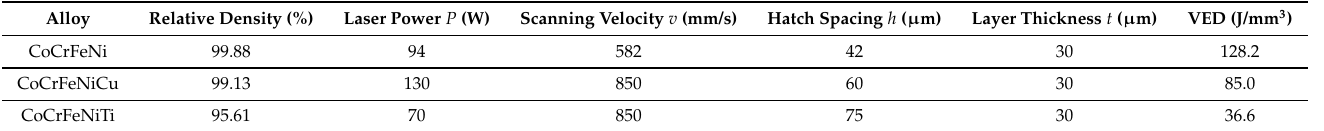
Table 3. SLM processing parameters and the calculated VED for the sample with highest relative density for each alloy.